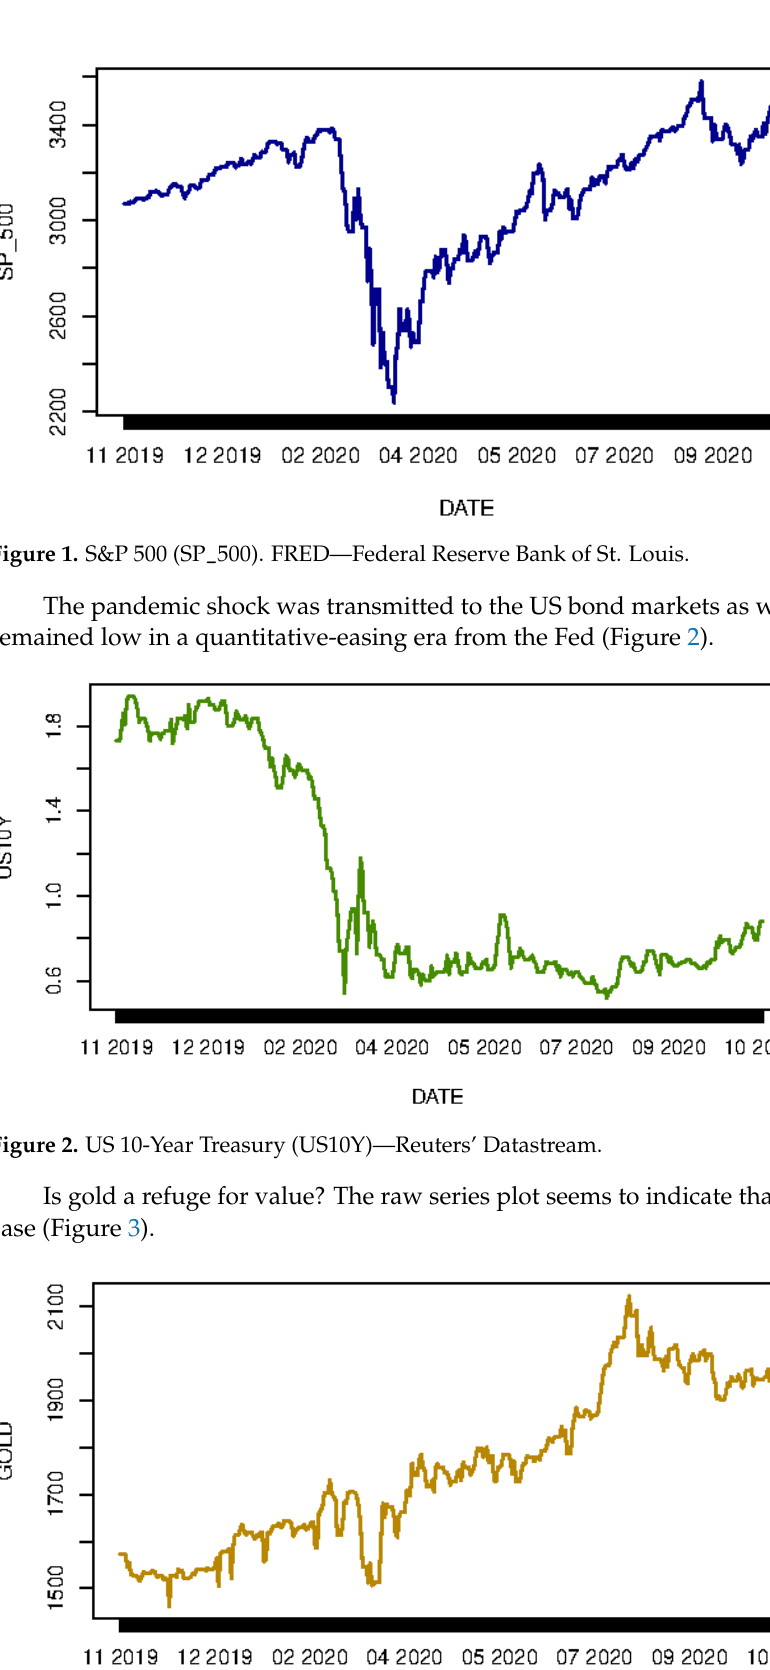
Figure 3. Gold bullion price per ounce (GOLD)—Reuters’